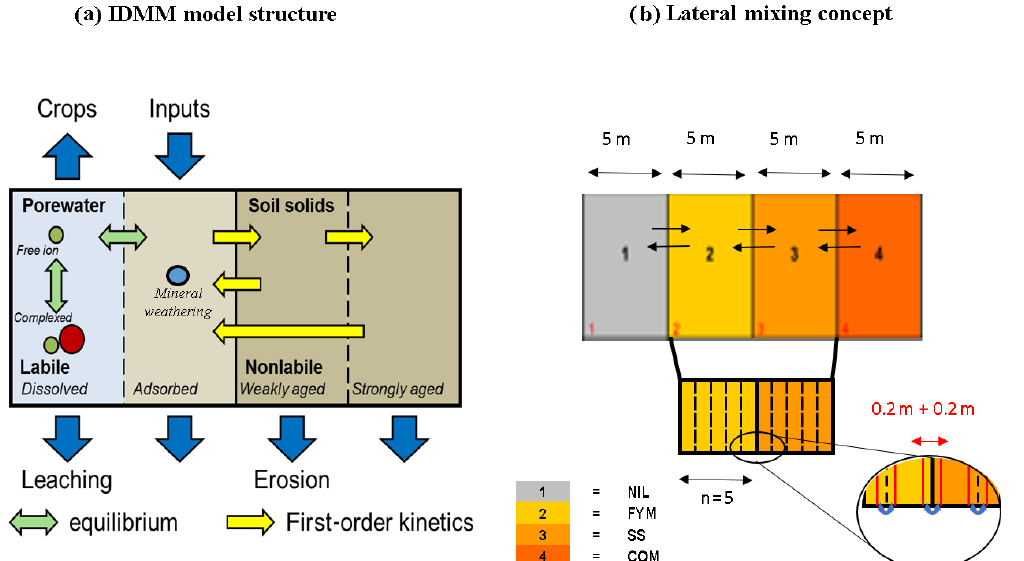
Figure 2. The IDMM model with lateral mixing. (a) The description of the model structure. (b) The description of the soil lateral mixing method.